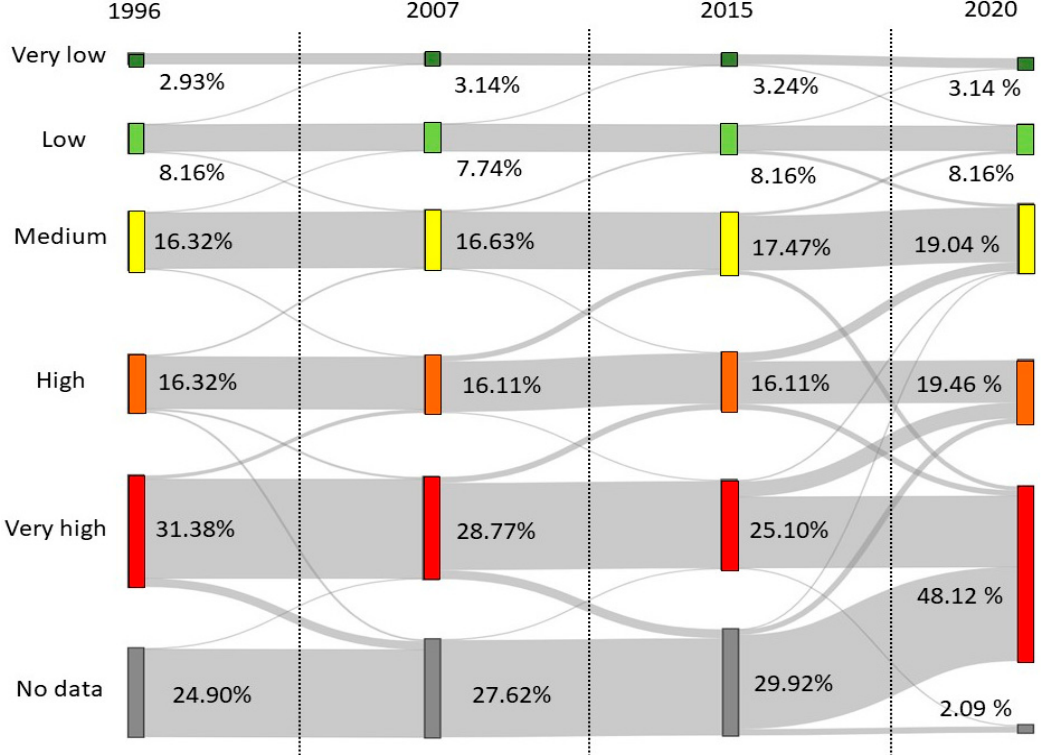
Figure 2. Sankey matrix with the evolution of the reticular fragmentation index of Ecuadorian mangrove forests in the years 1996, 2007, 2015, and 2020.